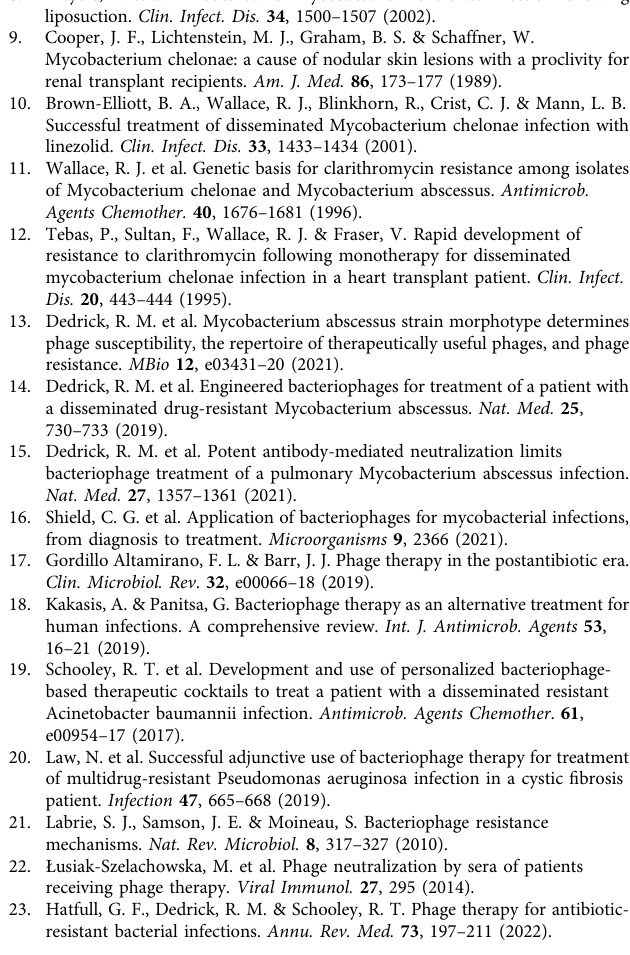
Fig. 3 Bacteriophages for therapy of M. chelonae . A Ten-fold serial dilutions of each phage (left) were spotted onto top agar overlays of M. smegmatis mc 2 155 and M. chelonae GD153. Phages: 1, BPs Δ 33 HTH_HRM10; 2, BPs Δ 33 HTH_HRM GD03 ; 3, Muddy; 4, Muddy_HRM GD04 ; 5, Itos; 6, Adephagia Δ 41 Δ 43